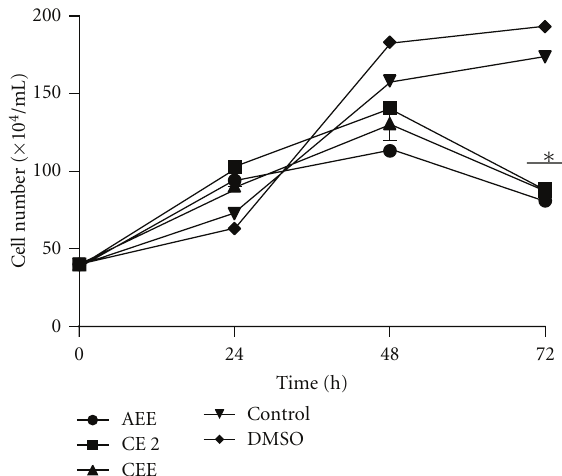
Figure 2: Antiparasitic activity exhibited by fractions of Laennecia confusa . Leishmania donovani promastigote growth inhibition was evaluated after incubation of the parasites with the compounds. Untreated promastigotes and DMSO were used as negative controls. Control: untreated promastigotes. Shown is the mean ± SD of three independent experiments. ∗ P value <